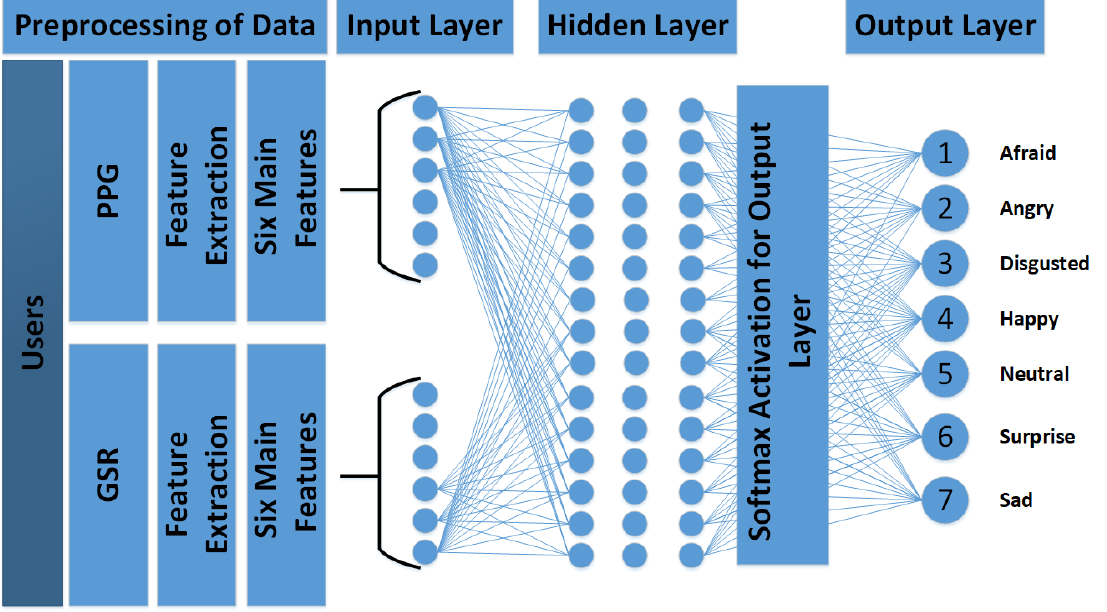
Figure 5. Structure of the 1D CNN used to classify emotions.